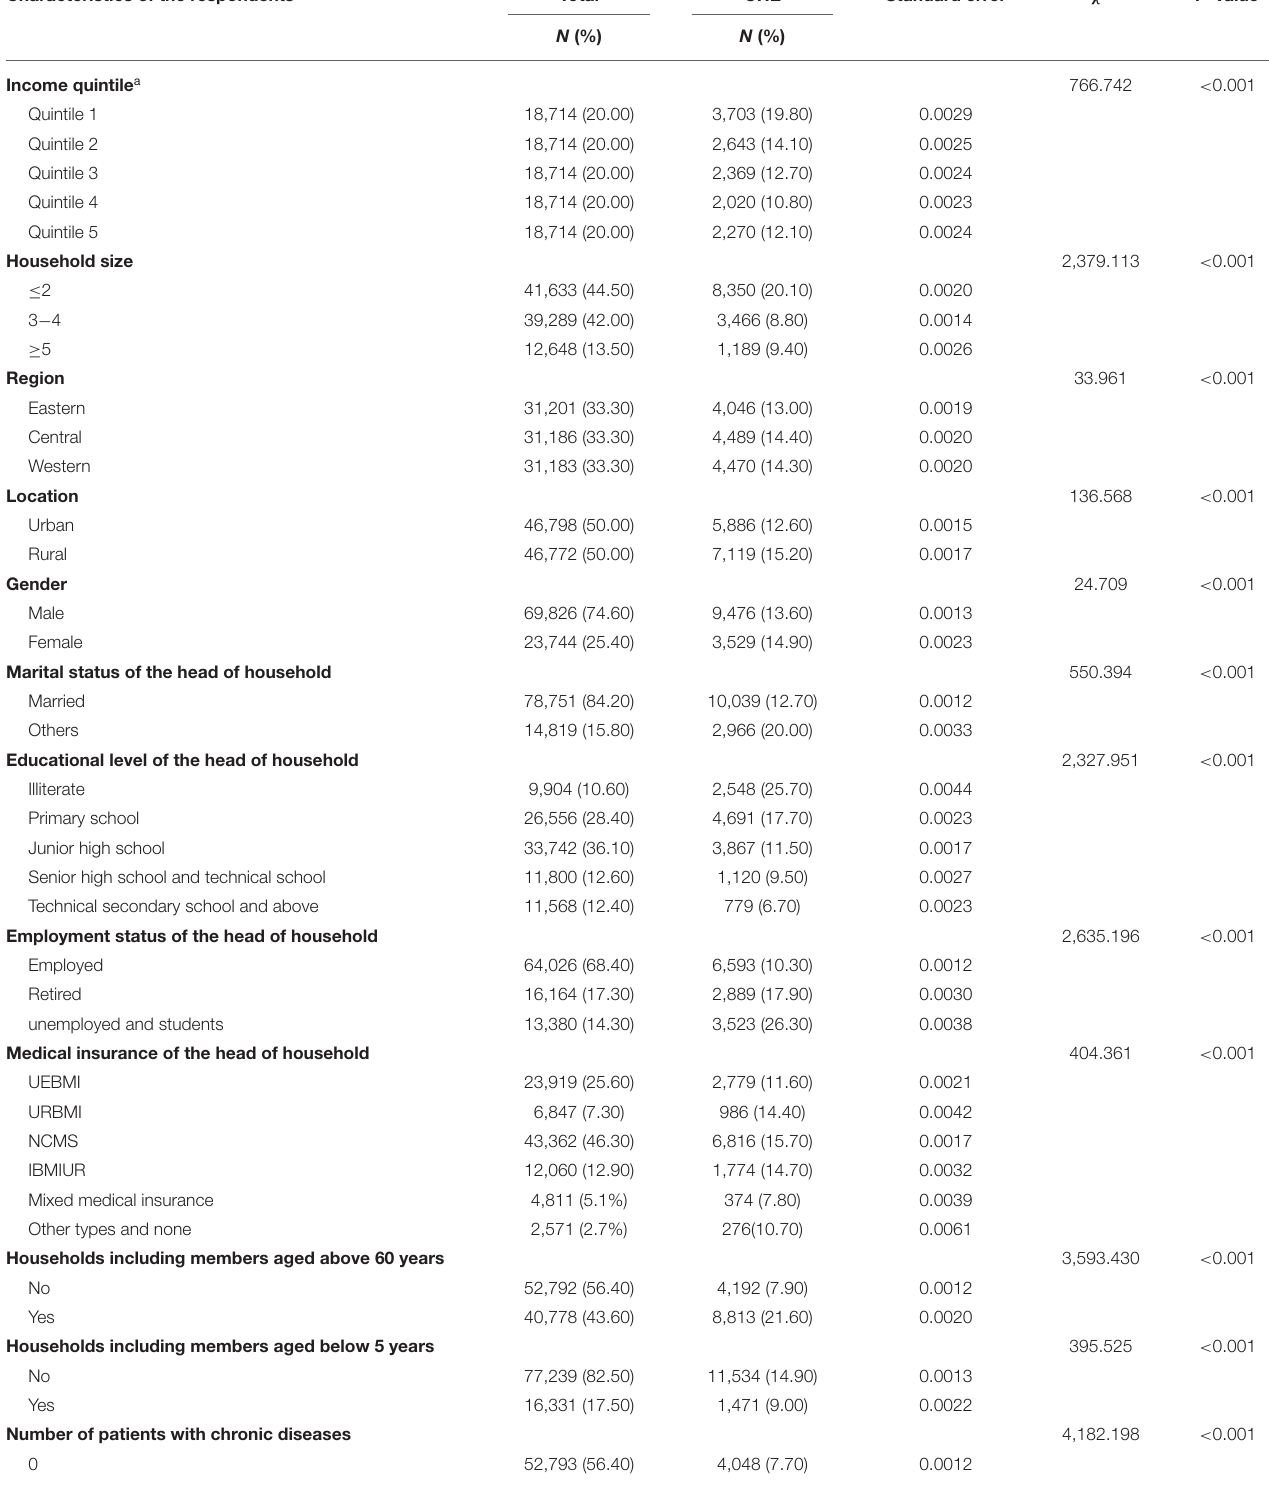
TABLE 3 | Univariate analysis of factors associated with CHE. Characteristics of the